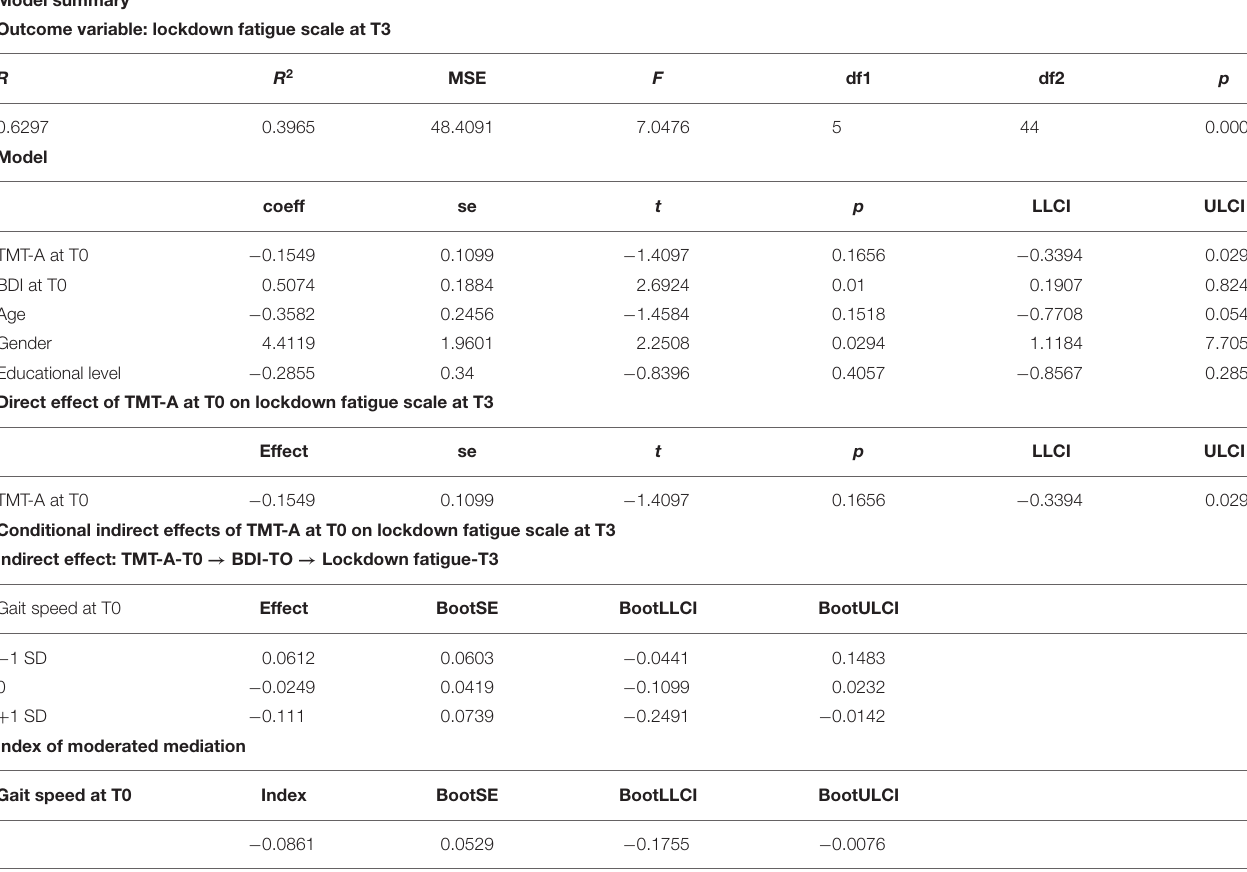
TABLE 6 | Moderated-mediation analysis for predicting lockdown fatigue scale at T3 based on TMT-A, BDI, and gait speed at T0. Model